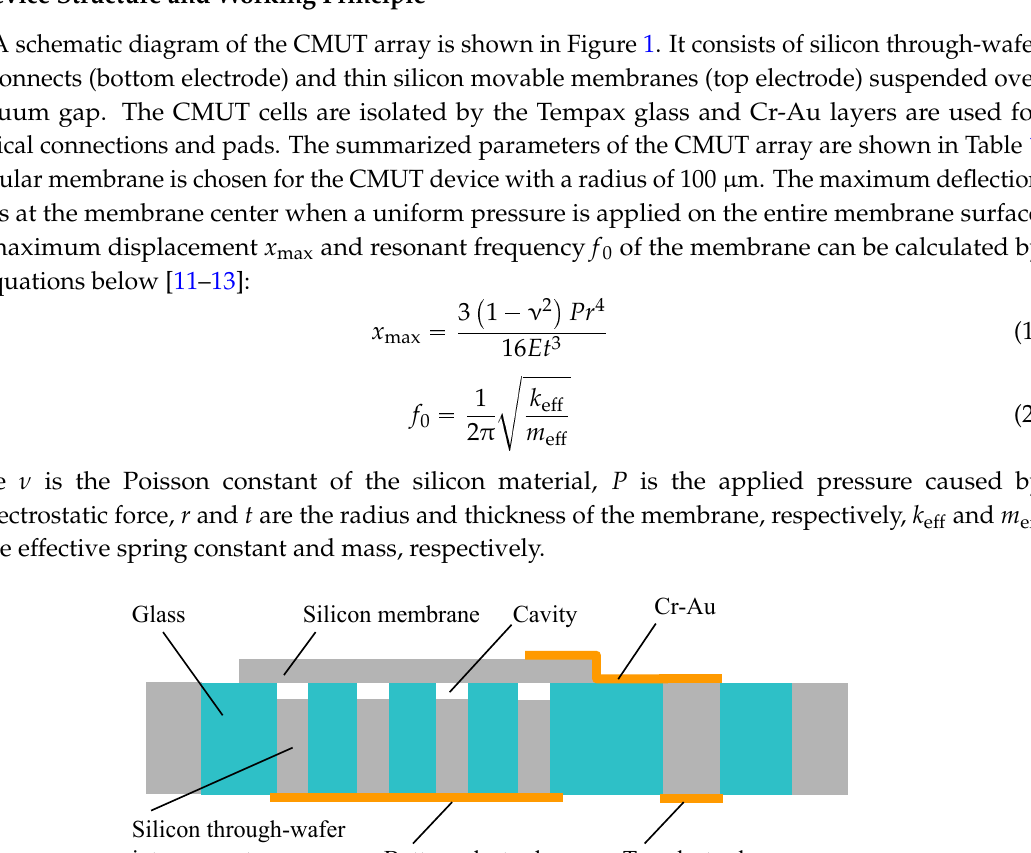
Figure 1. Device